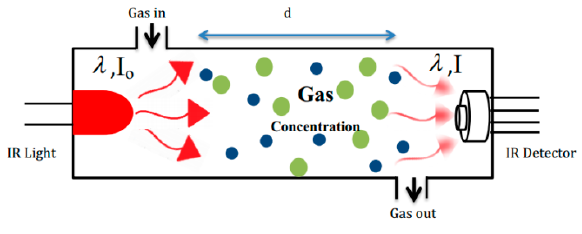
Figure 1. Beer–Lambert's theorem.